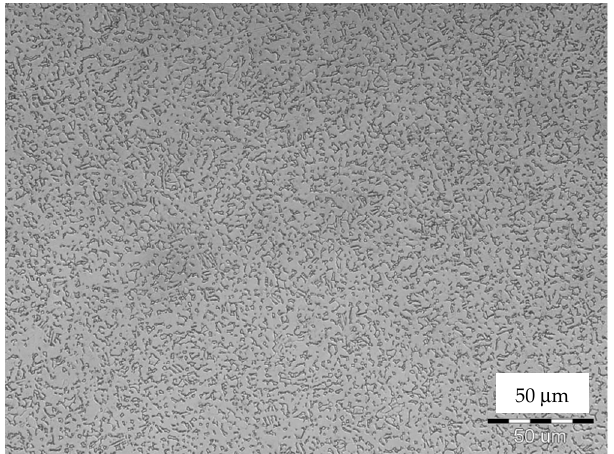
Figure 1. Optical microscopy (OM) microstructure image of etched Ti6Al4V specimen composed of two phases: light α and dark transformed β (etched).